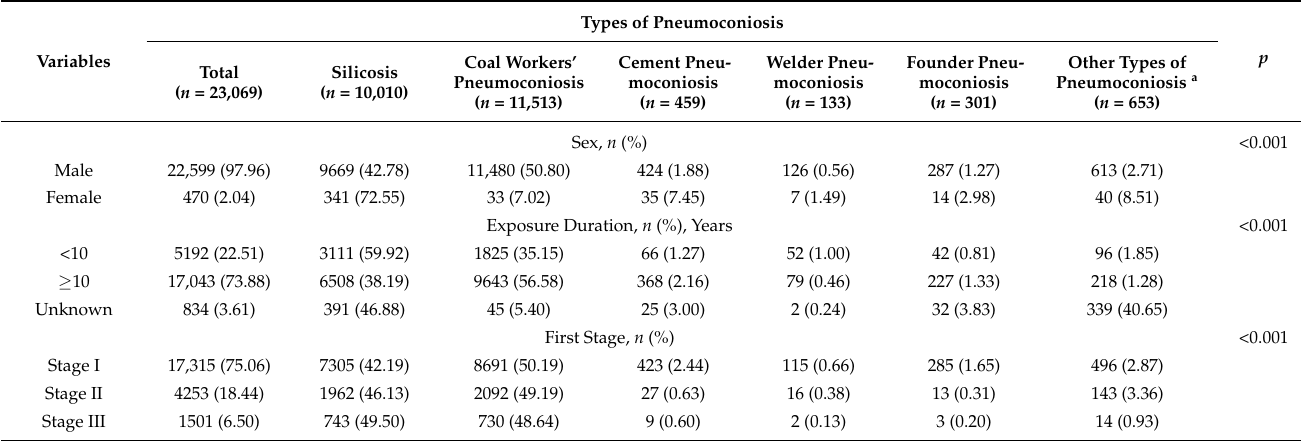
Figure 1. Numbers of pneumoconiosis cases in Hubei province, China, 1949 – 2019. Table 1. Basic Characteristics of Pneumoconiosis Patients in Hubei Province,